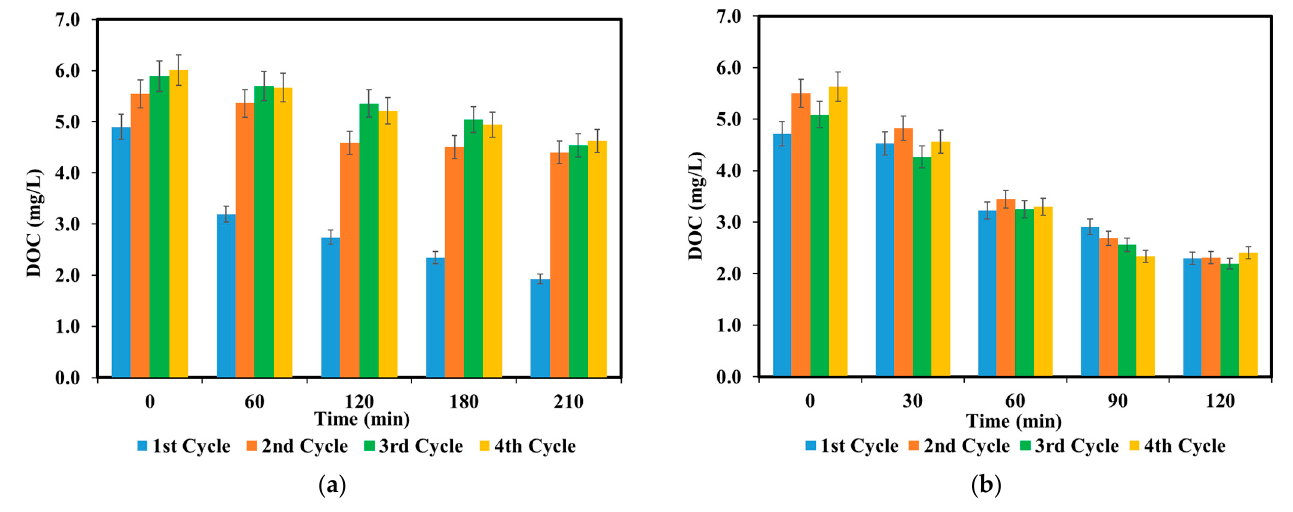
Figure 3. Changes in DOC values for LF/UV − A ( a ) and LF/PS/UV − A ( b ) treatments. Experimental conditions: RB5 = 20 mg/L; pH = 3; LF = 0.5 g/L; PS = 0.6 mM; I 0 = 0.5 W/L (UV − A); and t = 210 min for LF/UV − A and t = 120 min for LF/PS/UV − A treatment.